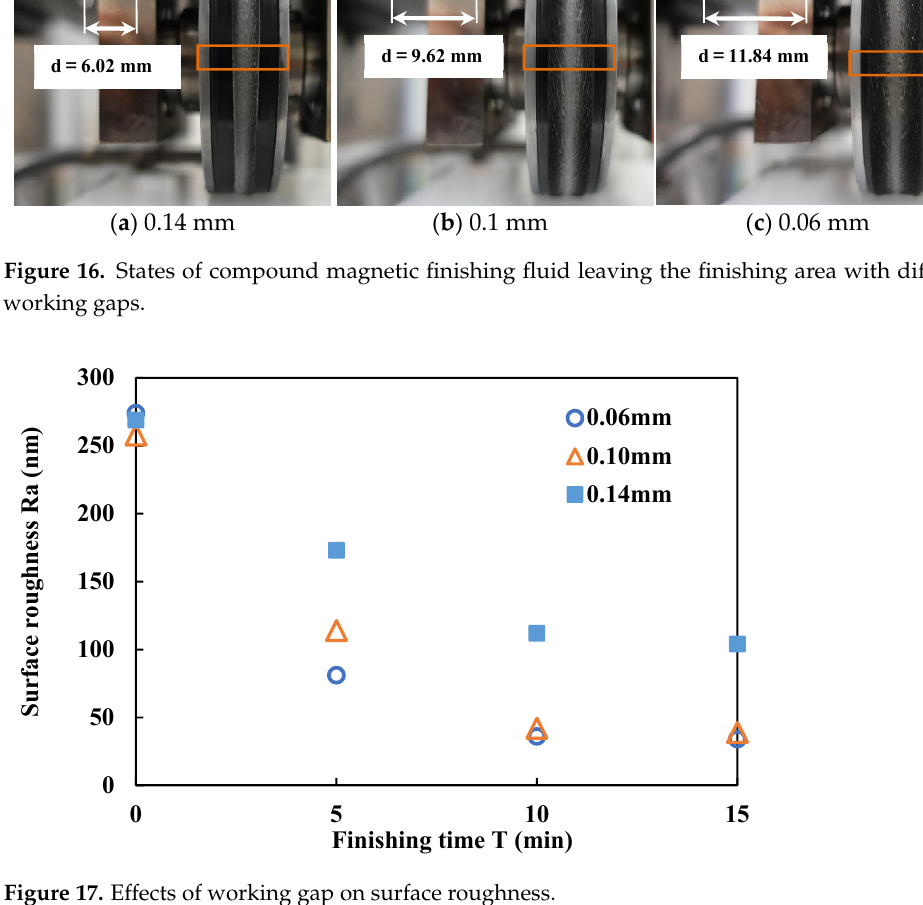
Figure 17. Effects of working gap on surface roughness.